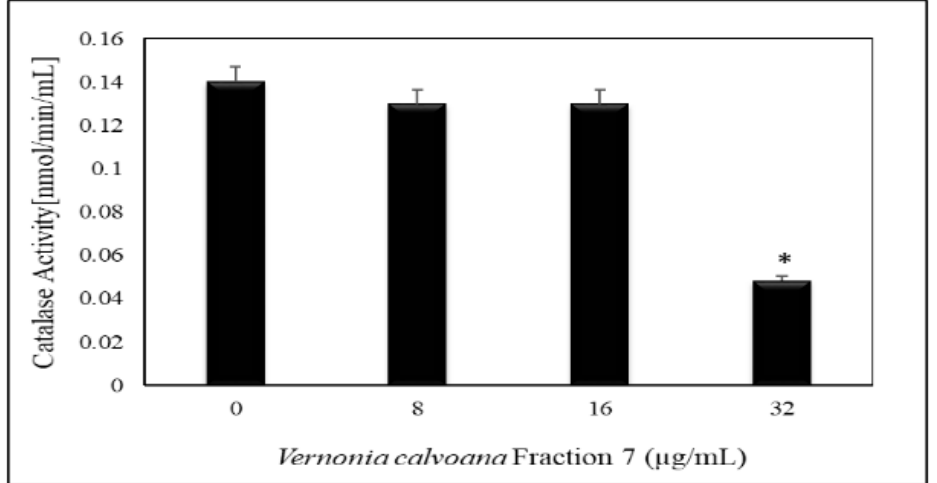
Figure 4. Effect of Vernonia calvoana fraction 7 (VC F7) on catalase activity in untreated and treated OVCAR-3 cells for 48 hours. The doses that were found to be statistically significantly different ( p < 0.05) compared to the control are denoted by (*) according to ANOVA Dunnett.